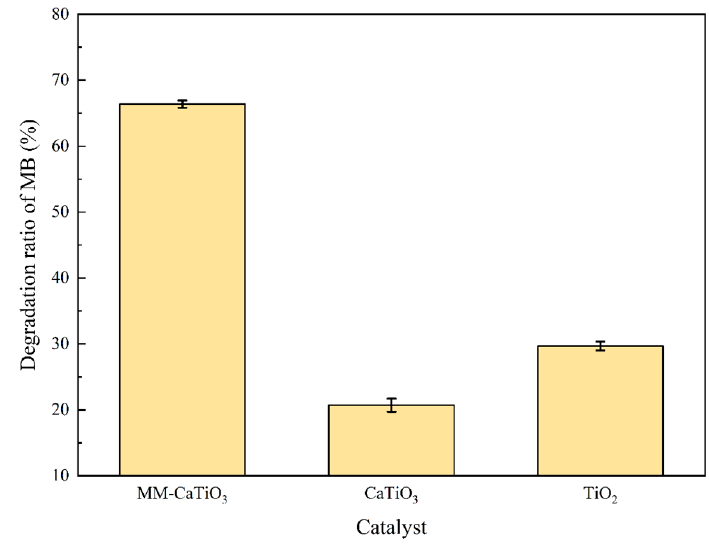
Figure 11. The photocatalytic degradation performance of catalysts.